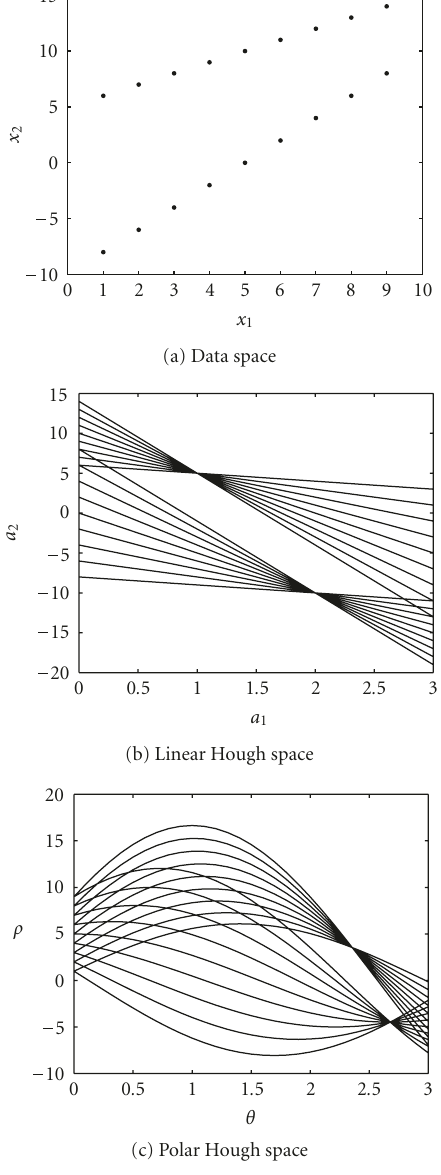
Figure 2: Illustration of the “classical” Hough transform: a point ( x 1 , x 2 ) in the data space (a) is mapped (b) onto the line { ( a 1 , a 2 ) | a x x = − a } in the linear parameter space R 2 or (c) onto a 2 1 1 + 2 translated sine curve { ( θ , ρ ) | ρ = x 1 cos θ + x 2 sin θ } in the polar parameter space [0, π ) × R + 0 . The Hough curves of points belong- ing to one line in data space intersect in precisely one point a in the Hough space—and the data points lie on the line given by the parameter a